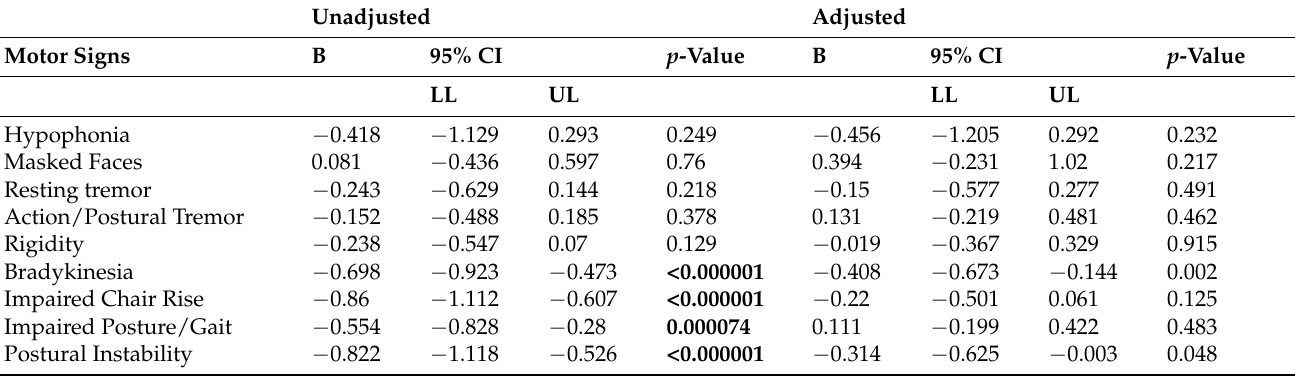
Table 4. Linear regression analysis for association between motor signs and attention.